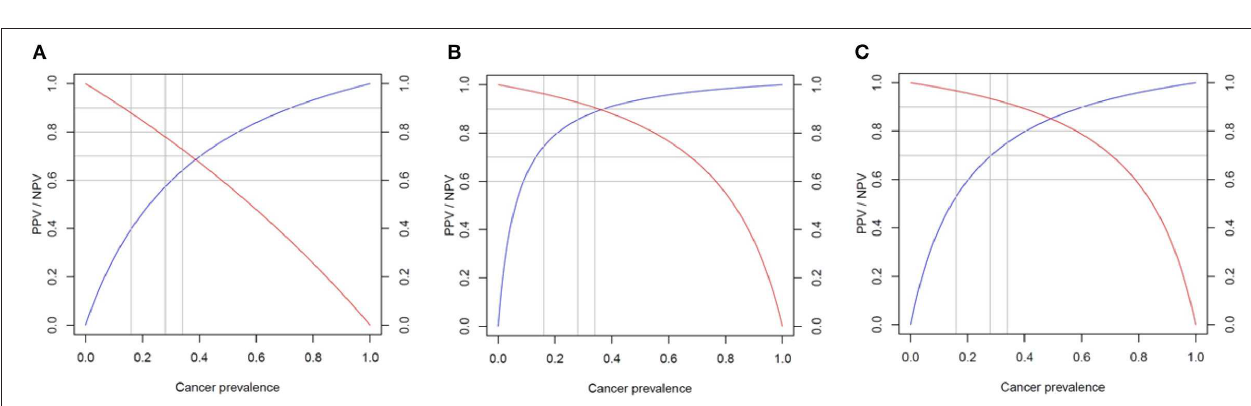
FIGURE 3 | Predicted performance of each score in populations with different cancer prevalence. Negative predictive value (NPV) in red and positive predictive value (PPV) in blue. (A) Ultrasound score (X US ); (B) genomic classifier score (X GC ); and (C) total risk score